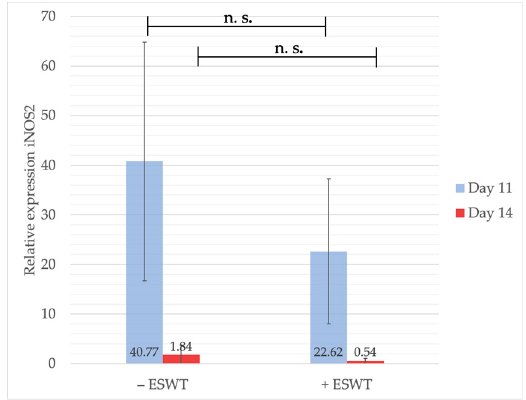
Figure 10. Gene expression analysis of iNOS2 via qPCR. Higher levels of iNOS2 could be shown within the control group compared to specimens treated with ESWT at EDD-11, although no statistically significant effect was detected. Four days after treatment, iNOS2 expression was still higher within the untreated control group compared to the ESWT-treated group. Shown are means ± SD, n.s. = not significant. EDD-11: Independent-Samples t -Test between experimental groups and untreated control, normally distributed, homogeneity of variance. EDD-14: inhomogeneity of variance.